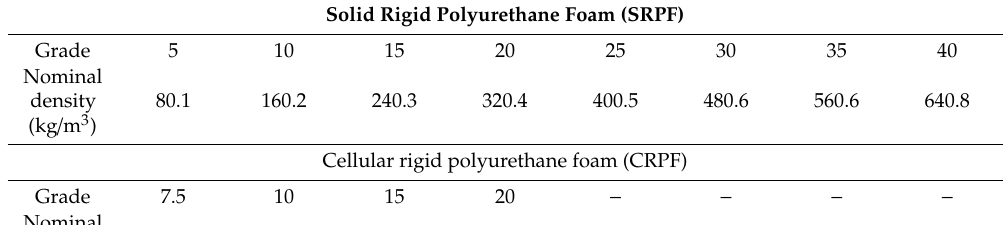
Table 2. Bone models used in this study.